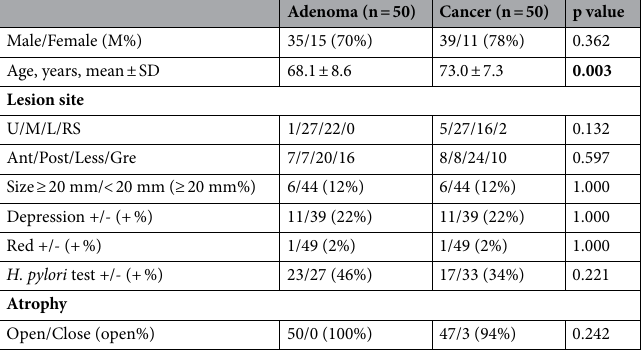
Table 2. Post-matching patient characteristics. Significant values are in bold. U upper, M middle, L lower, RS remnant stomach. Ant Anterior wall, Post posterior wall, Less lesser curvature, Gre greater curvature.